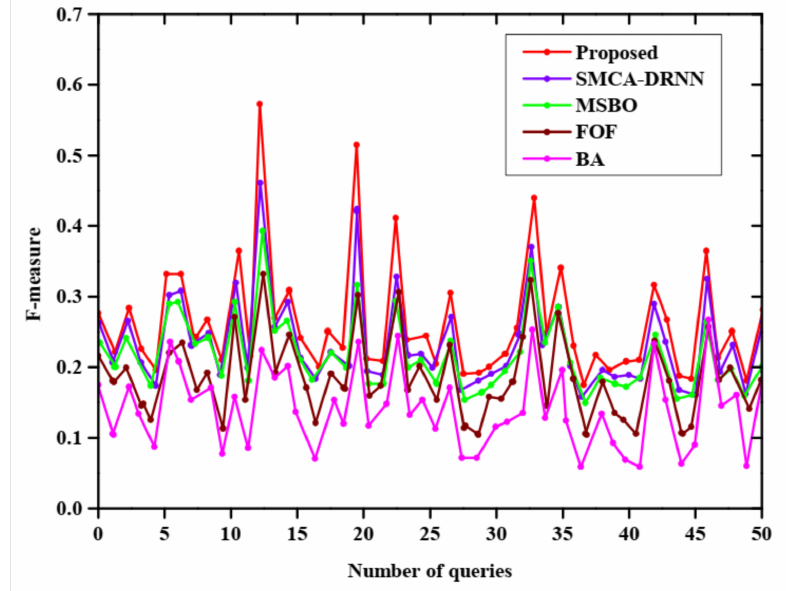
Figure 8. F-measure with query